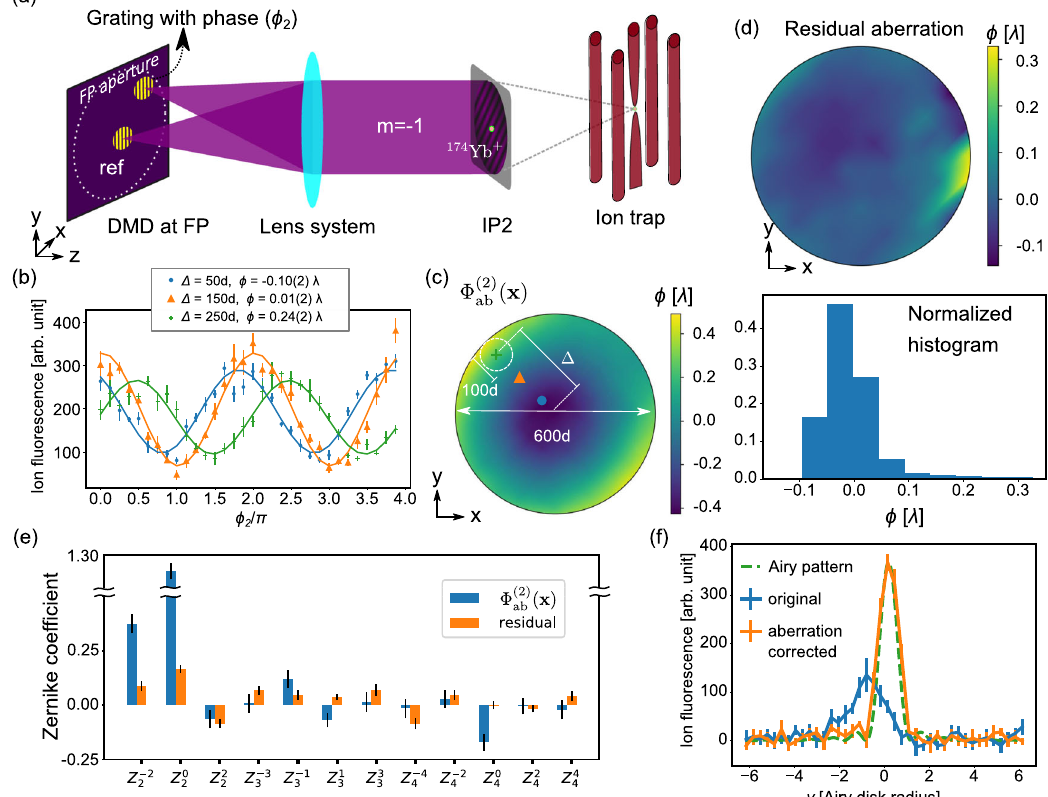
Fig. 3 Aberration characterization and compensation with a single ion. a Schematic of aberration measurement with a single 174 Yb + ion in a “ four-rod ” trap. b Interference fringes measured by observing the 2 S 1/2 − 2 P 1/2 fl uorescence of the ion. For each value of phase ϕ 2 of the scanning grating patch, in steps of π /8 from 0 to 4 π (with the redundancy for a robust phase extraction), we acquire the fl uorescence for 100 ms. The 369.5 nm light is red-detuned by ~20 MHz from resonance, for maximizing the signal-to-noise ratio while Doppler-cooling the ion. We estimate the peak optical intensity of the fringes on the ion to be about 0.5 I sat , where I sat is the saturation intensity. Each data point is an average over fi ve identical experiments, and error bars represent the standard error. Each solid line is a cosine wave at a fi xed angular frequency of 1, reconstructed from the amplitude and phase ϕ obtained from fast Fourier Transform (FFT) of the data set. c The aberration ð x Þ (corresponding scanning patches for plots in b are superimposed). d The residual aberration phase map and normalized phase map Φ ð 2 Þ ab ð x Þ and the residual histogram (with the same method in Fig. 2b) after aberration compensation. e First few Zernike coef fi cients of Φ ð 2 Þ ab aberration, extracted in the same manner as in Fig. 2. f 369.5 nm single-ion addressing beam pro fi le before (blue) and after (orange) the aberration correction, as measured (see Methods) by ion fl uorescence. Error bars indicate the standard error over fi ve repeated measurements. The beam pro fi le is created by employing a grating over the entire FP aperture (diameter 600 d ), without any amplitude modulation. We scan the beam on the ion by adding a programmable tilt in the phase map. The spatial location of the beam (horizontal axis) at the ion is calculated from the known value of the tilt and the effective focal length. The effective NA here is 0.08 (the ideal Airy pattern is shown), corresponding to an Airy radius of 2.8 μ